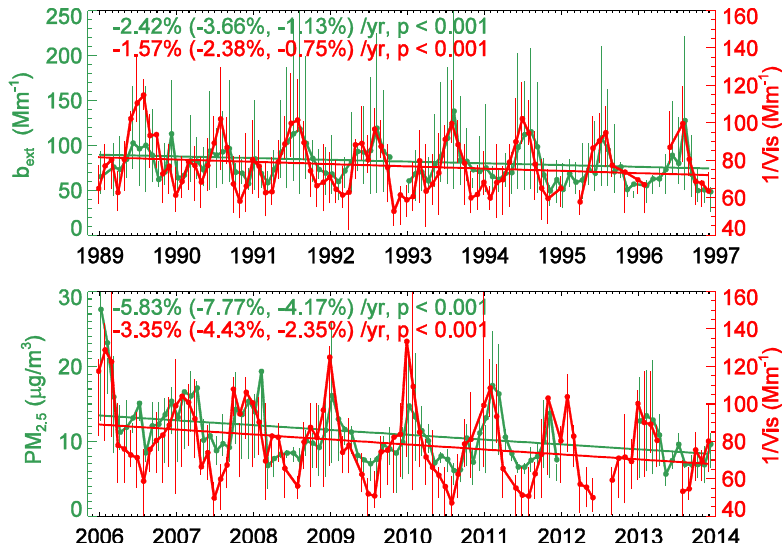
Figure 6. Composite time series and trends of (top) 1/Vis and b ext for collocated ISD and IMPROVE stations (Fig. 4) over 1989–1996 and (bottom) 1/Vis and PM 2 . 5 for collocated ISD and EMEP stations (Fig. 5) over 2006–2013. Only stations with significant trends of > 90% confidence are collocated. The long ticks on the horizontal axis indicate the January of the year. Data gaps represent months with less than 75% of the total grids. Error bars show the 25th and 75th percentile of all monthly values of collocated